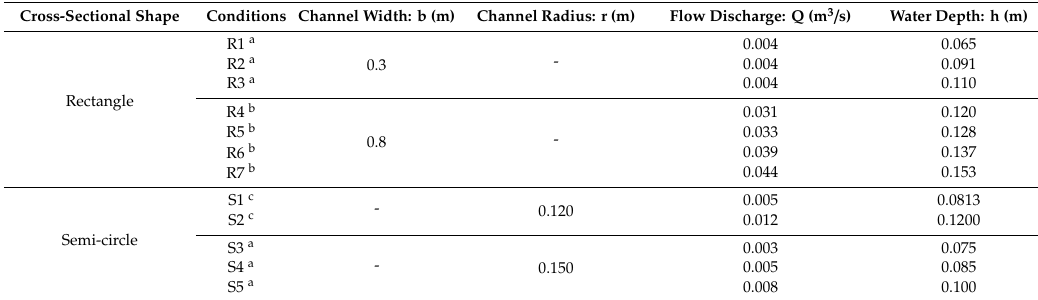
Table 1. Summary of experimental